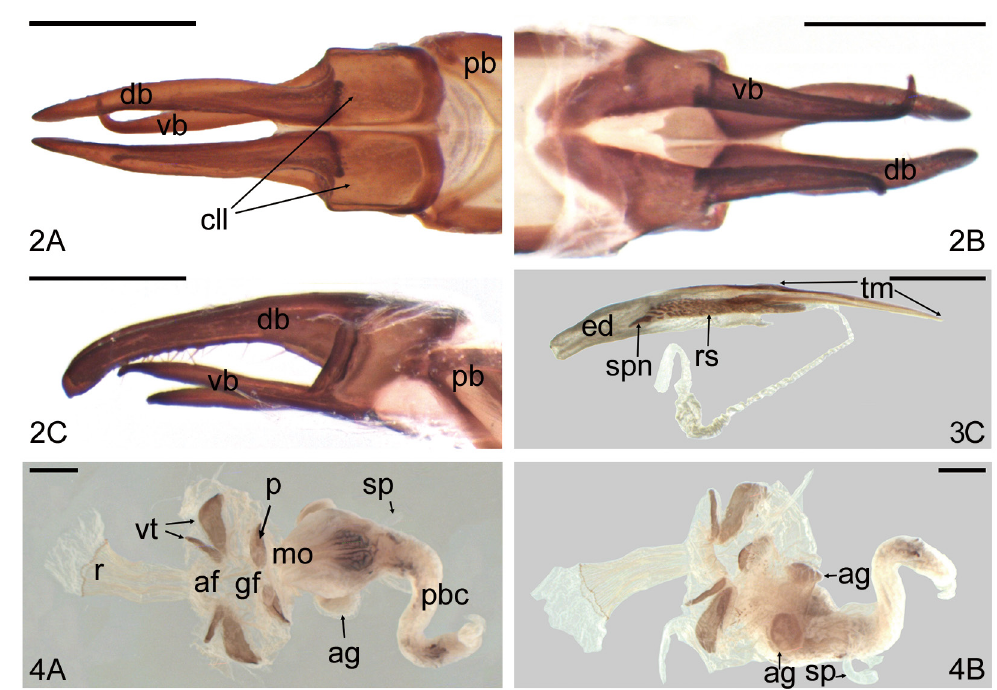
Figs 2–4. Morphotype I “ Trichophora ”. 2–3 . Male genitalia of M. trichophora (Fairmaire, 1891), paralectotype (MNHN). 2 . Parameres in dorsal (A), ventral (B) and lateral (C) views. 3 . Endophallus in lateral view. 4 . Female genitalia of M. abdominalis (Hope, 1831), lectotype (BMNH), in dorsal (A) and ventral (B) views. Scale bars = 1.0 mm.